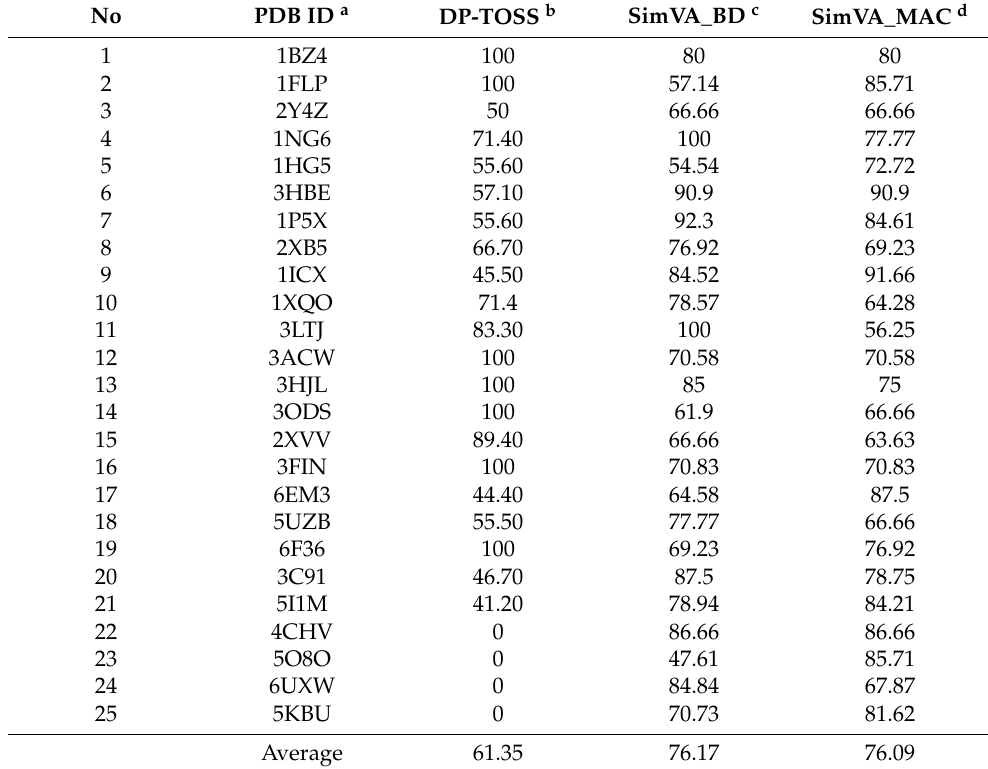
scoring function; d the accuracy of the SimVA algorithm using MAC scoring function.